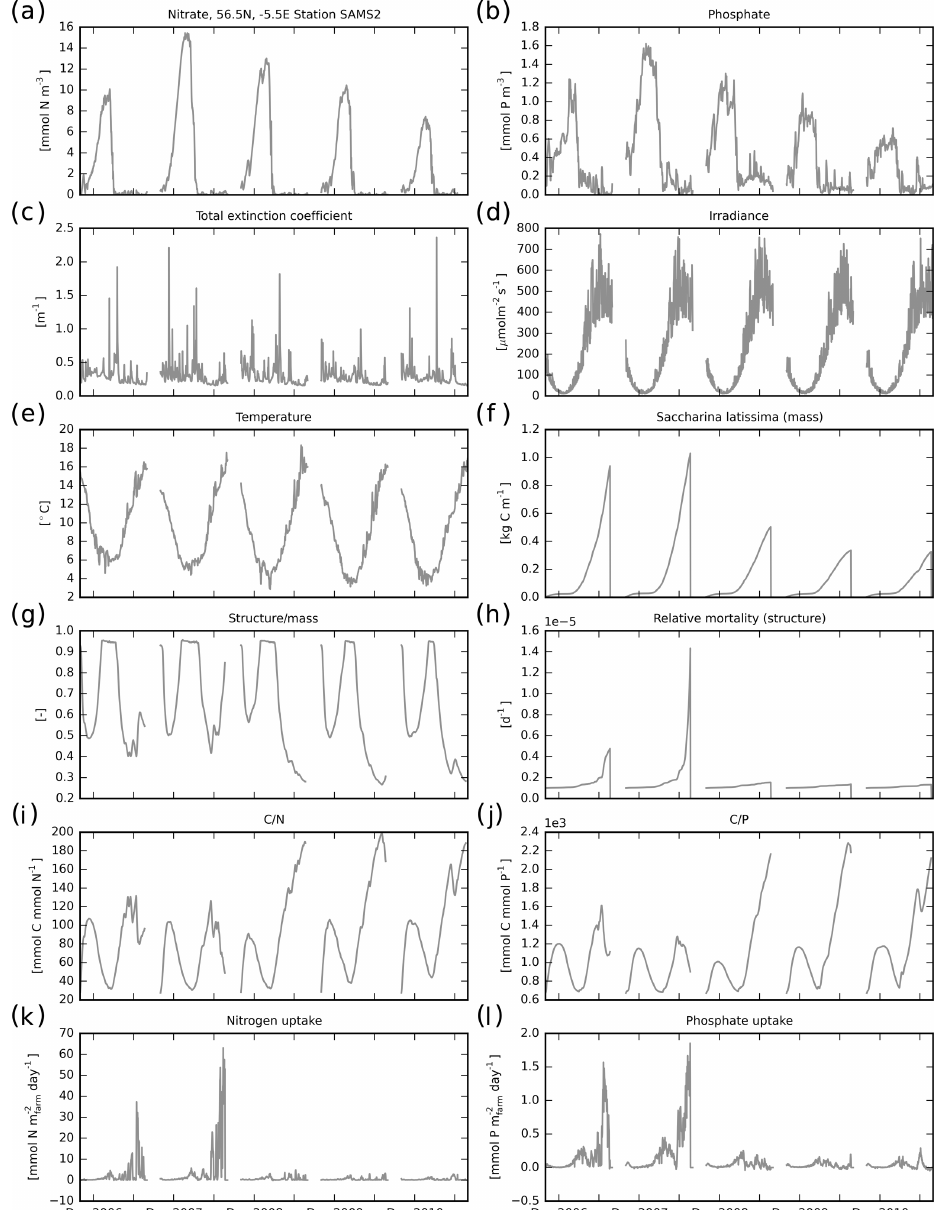
Figure 11. Model results for the Lynn of Lorne farm site. (a) Surface nitrate concentration; (b) surface phosphate concentration; (c) total extinction coefficient at the surface (excluding contribution by macroalgae); (d) irradiance at the surface; (e) surface water temperature; (f) macroalgae carbon biomass per metre of line; (g) mass of macroalgae structure over total macroalgae mass ratio; (h) relative mortality of macroalgae structure; (i) C / N ratio of macroalgae; (j) C / P ratio of macroalgae; (k) farm net nitrogen uptake; (l) farm net phosphate